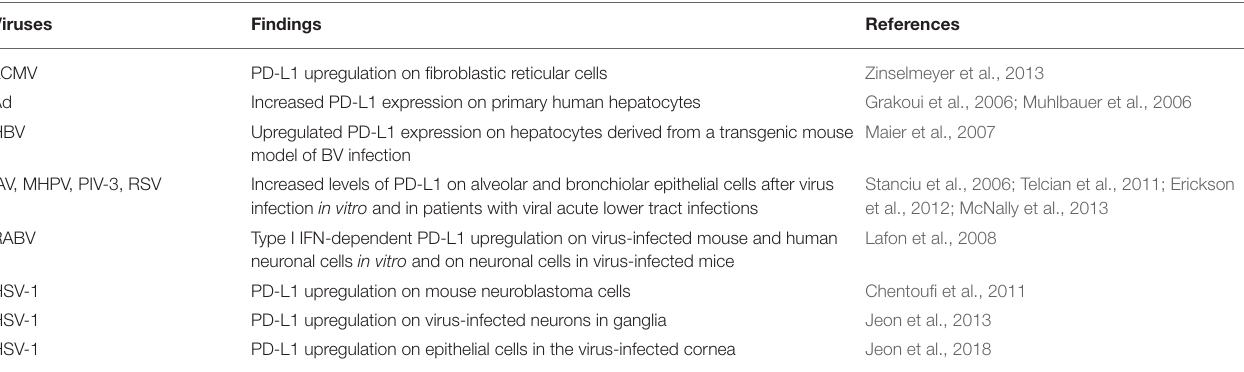
TABLE 2 | Virus-induced PD-L1 upregulation on non-hematopoietic cells. Viruses